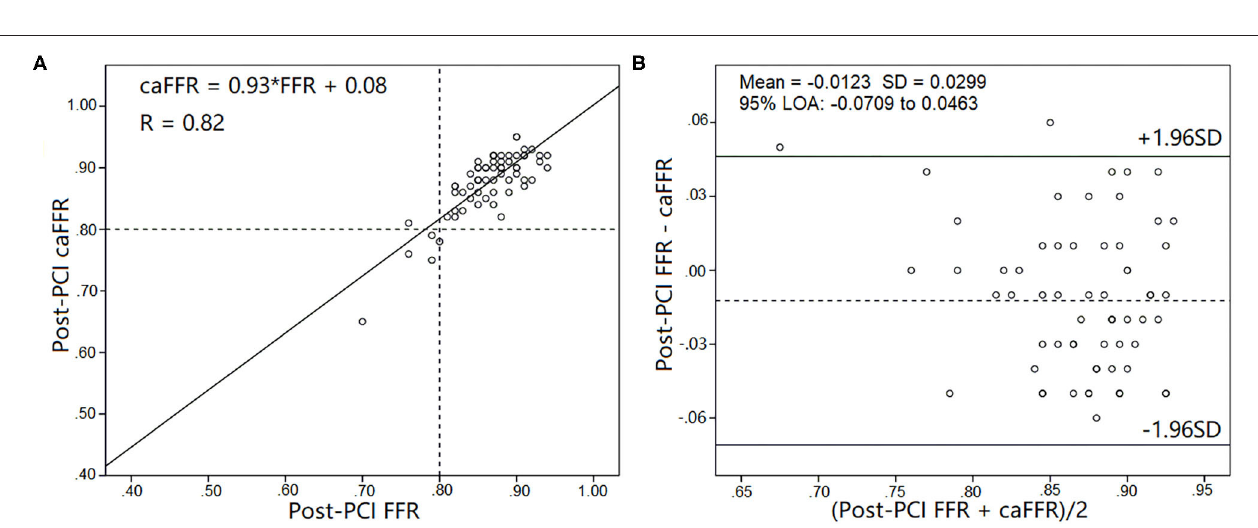
FIGURE 5 | Correlation and agreement between post-PCI wire-based FFR and caFFR values ( n = 65). (A) Strong correlation between post-PCI wire-based FFR and caFFR values (caFFR = 0.93 × FFR + 0.08, R = 0.82, 95% CI: 0.762–1.092). (B) Good agreement between post-PCI wire-based FFR and caFFR values by the Bland–Altman analysis (bias: − 0.0123 ± 0.0299; 95% LOA − 0.0709 to 0.0463). CI, confidence interval; LOA, limits of agreement; LAD, left descending artery; FFR, fractional flow reserve; PCI, percutaneous coronary intervention; caFFR, coronary angiography-derived FFR.